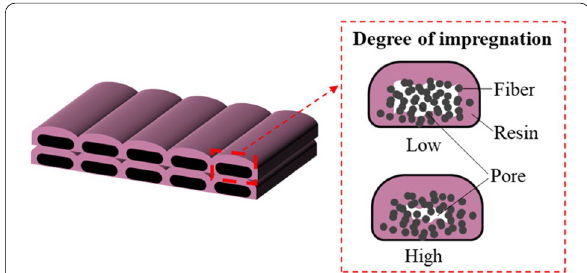
Figure 13 Continuous fiber composite with different impregnation